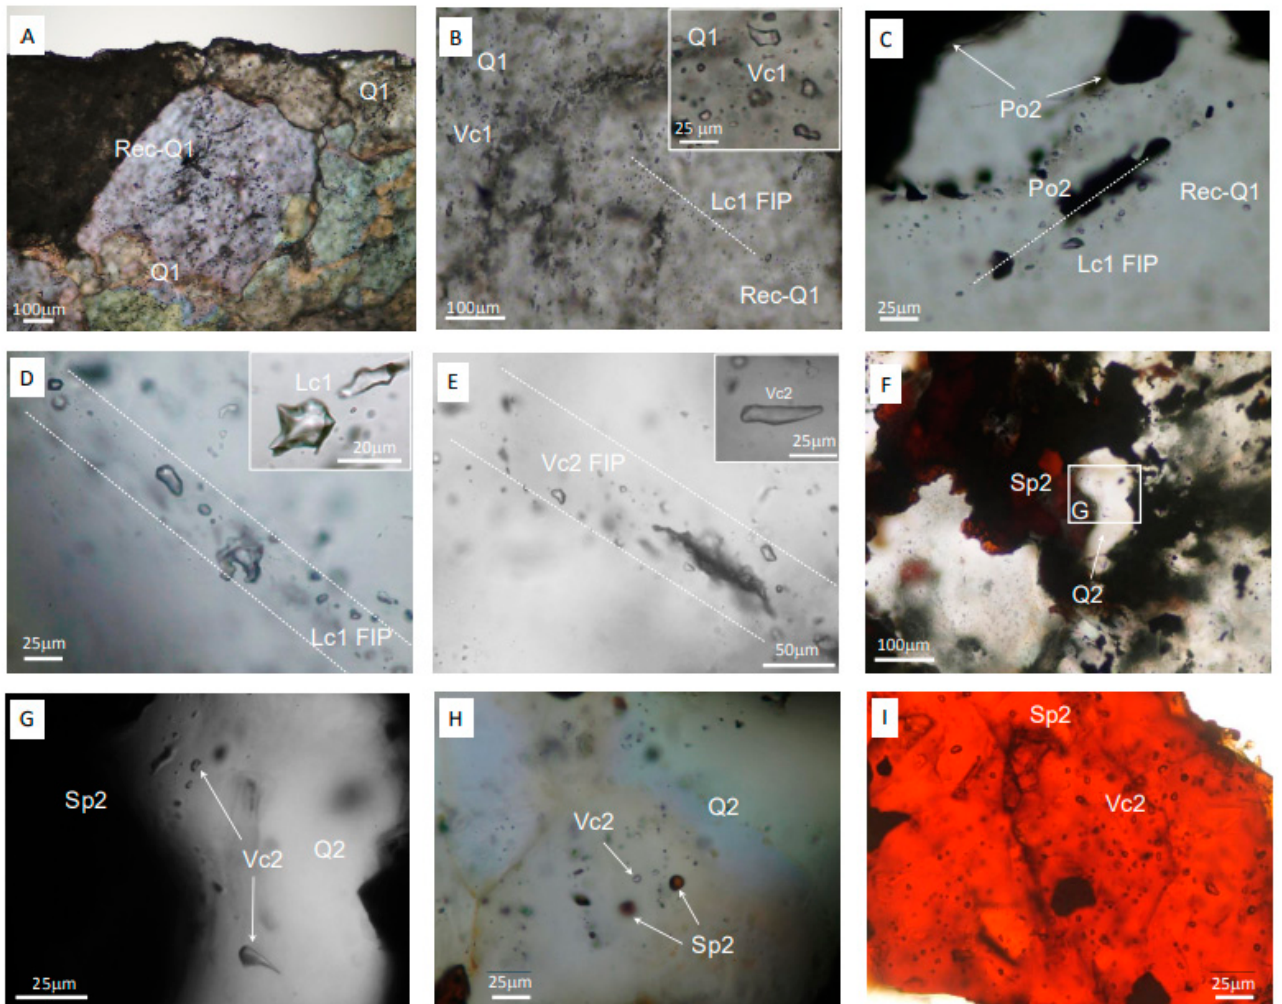
Figure 8. Fluid inclusions from Koudiat Aïcha: early stages. ( A ): Quartz 1 (Q1) from early veins with dark aspects, due to the abundance of fluid inclusions, and recrystallized microdomains (Rec-Q1). ( B ): Detail of ( A ) showing early Vc1 FIs and Lc1 FIs in fluid inclusion planes (FIPs) crosscutting Q1 and recrystallized Q1. ( C ): Association of pyrrhotite 2 (Po2) with Lc1 FIs in microfissures crosscutting recrystallized Q1 (Rec-Q1). ( D ): Lc1 FIP in recrystallized Q1. ( E ): Vc2 FIs in planes crosscutting recrystallized Q1. ( F,G ): Sphalerite 2 (Sp2) surrounded by quartz 2 (Q2). ( H ): Association of sphalerite 2 (Sp2) with primary Vc2 fluid inclusions in quartz 2 (Q2). ( I ): Scattered (primary) Vc2 FIs in sphalerite 2 (Sp2).